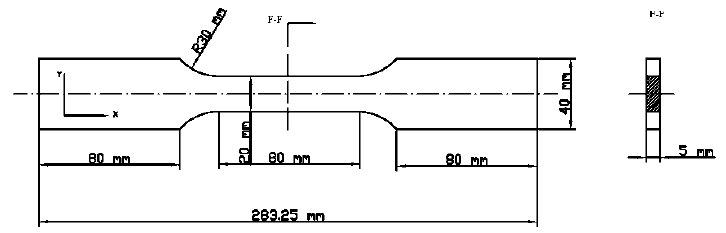
Figure 2. Geometrical dimension of specimen.